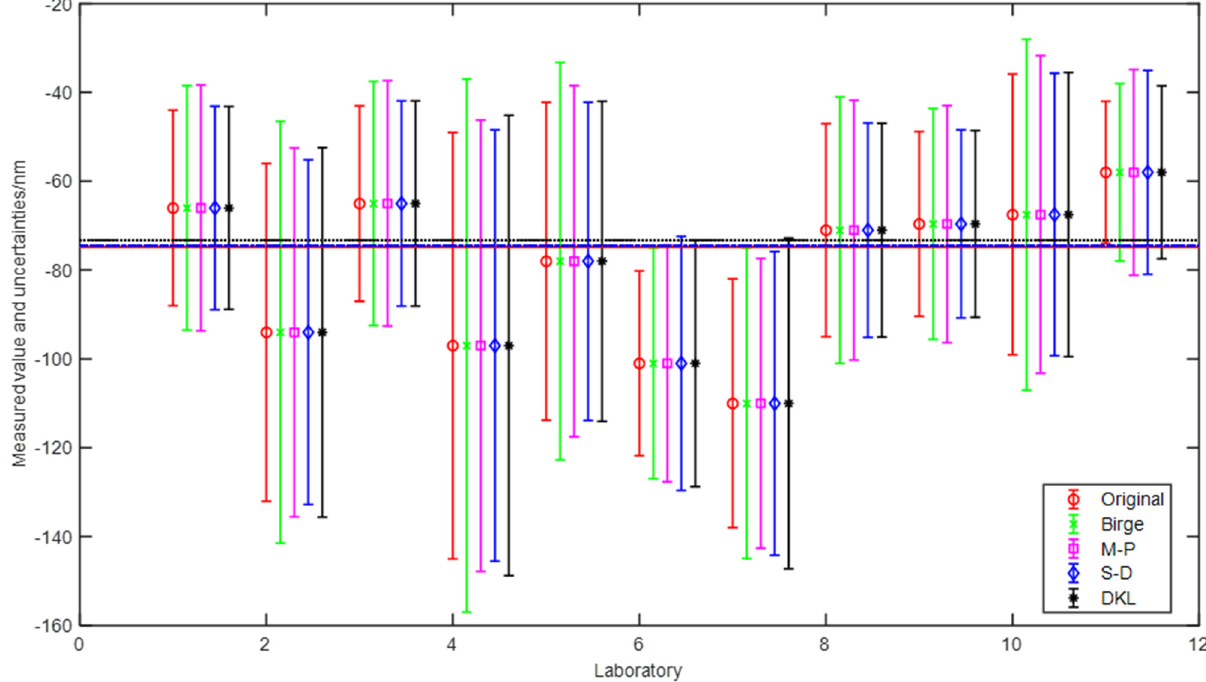
Fig. 2. Estimates and 95% con fi dence intervals of a 100 mm gauge block for various adjustment procedures. The graph shows the uncertainty bars x j ± 2 u j for the input uncertainties u 0 , the fi rst set of uncertainty bars in each group, and for the adjusted uncertainties u from the Birge, second set, Mandel-Paule (M-P), third set, steepest decent (S-D), fourth set and minimum relative entropy (DKL) procedures, fi fth set. The horizontal lines are the weighted means determined from the input uncertainties (solid red), steepest descent (blue dashed) and minimum relative entropy (black dotted).